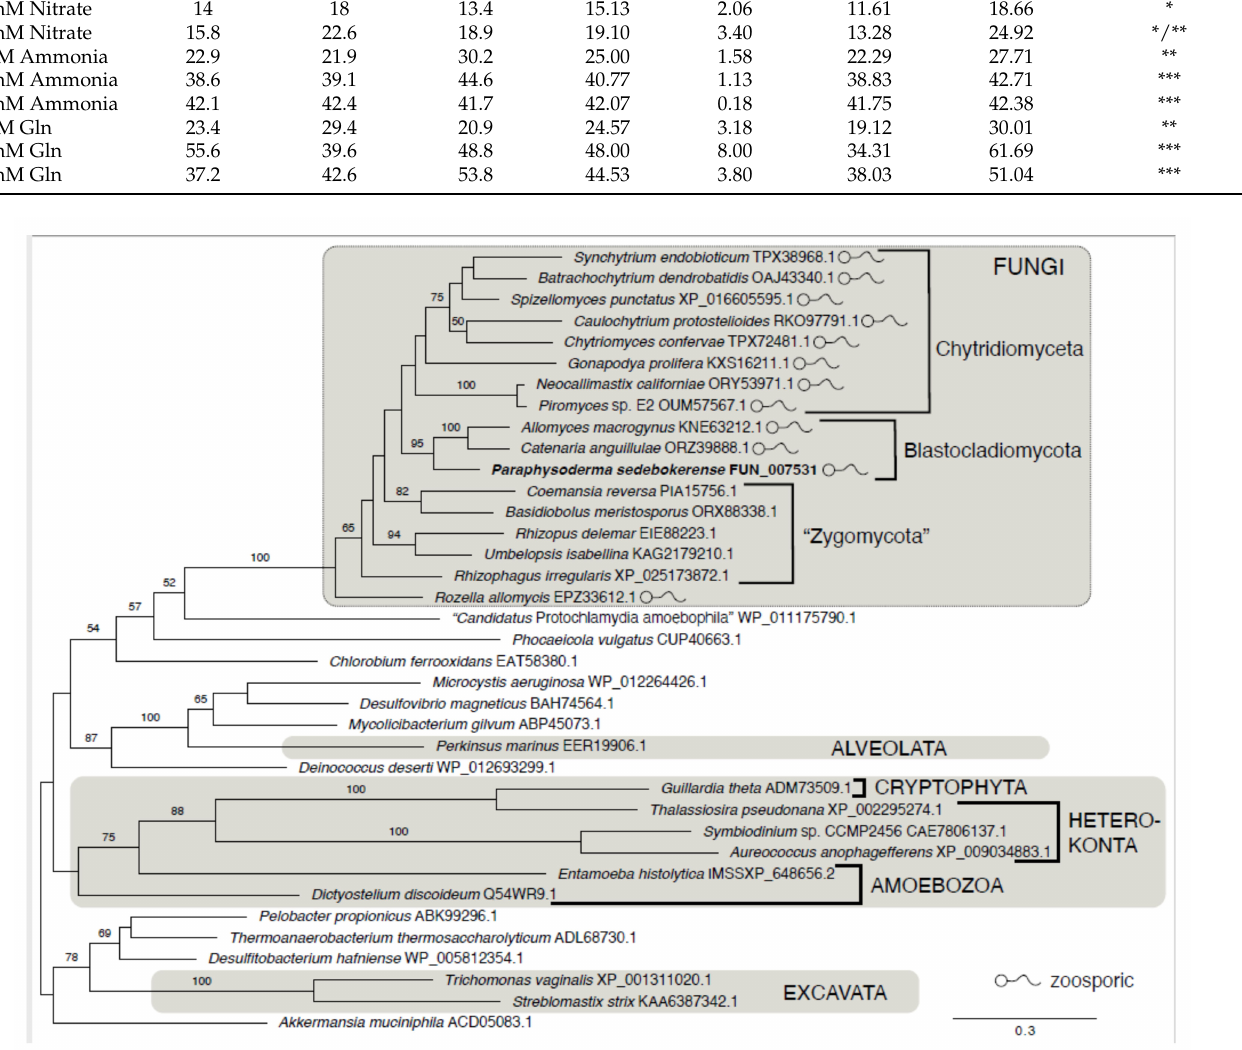
Figure 4. Phylogeny of glutamine synthetase type III proteins shows monophyly of fungal copies and a distribution restricted to early diverging lineages of fungi. Clades of eukaryotes are indicated by a grey background, and other sequences are from bacteria. Only bootstrap values of 50% are